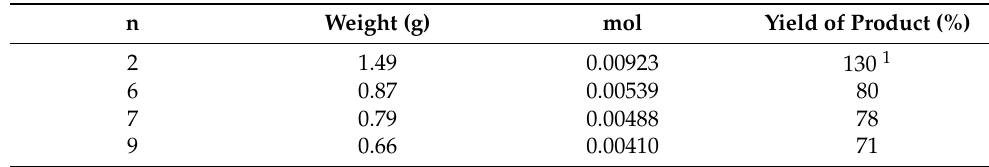
Table 3. Amounts of HMDS for cyclization of linear oligodichlorophosphazenes with general